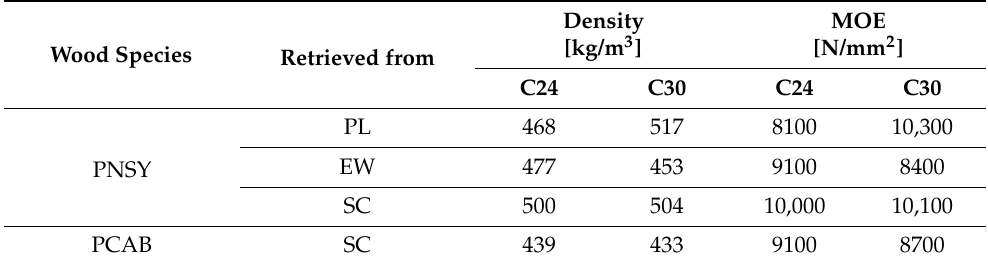
Table 1. Material data used in the analysis of numerical models of long frames in version A made of solid wood material.